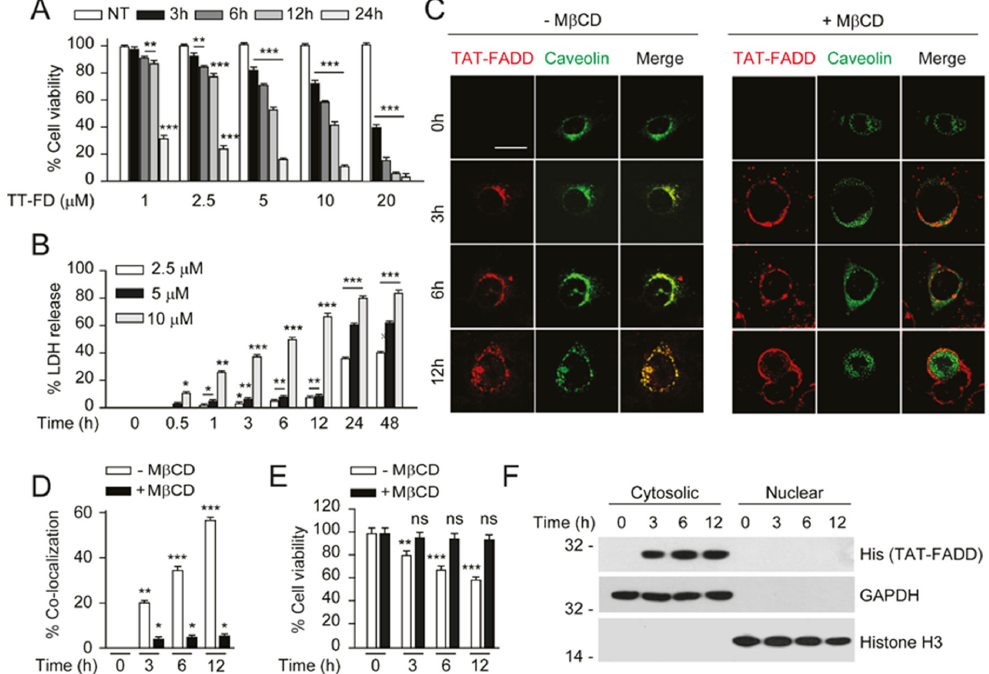
Figure 2. TAT ‐ FADD efficiently delivered inside the cells and retained in the cytoplasm. ( A , B ) HCT Figure 2. TAT-FADD e ffi ciently delivered inside the cells and retained in the cytoplasm. ( A , B )